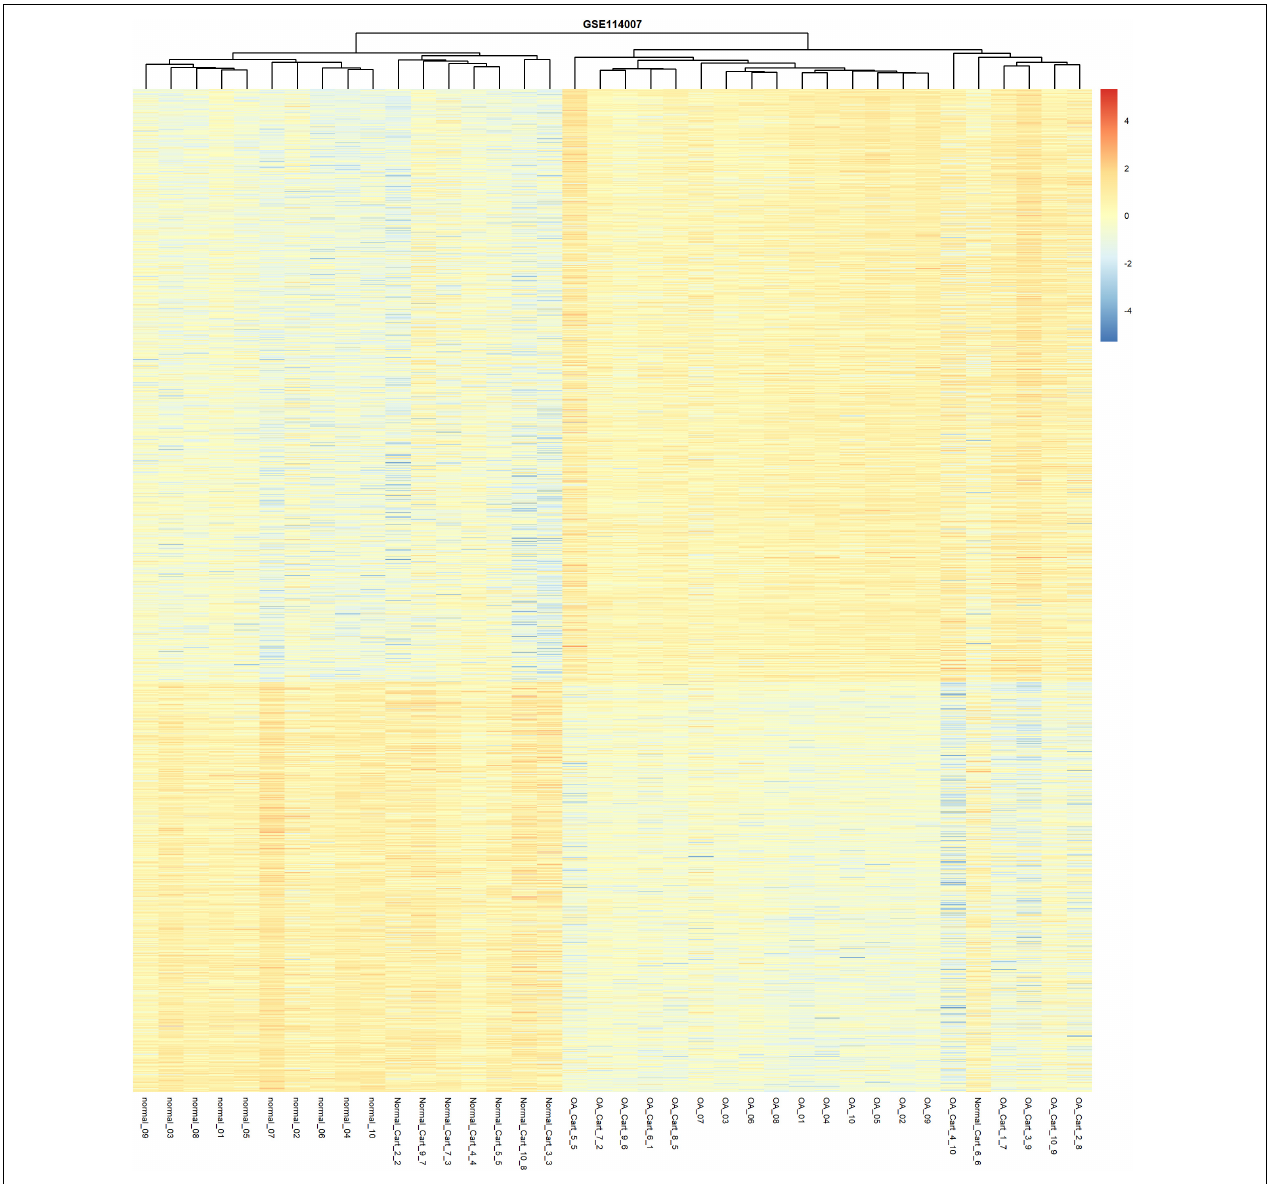
FIGURE 3 | Unsupervised hierarchical clustering of the DEGs, based on their expression levels, from the normal and OA articular cartilage samples using the cut-off criteria of abs (logFC) > 1 and adjusted P -value <